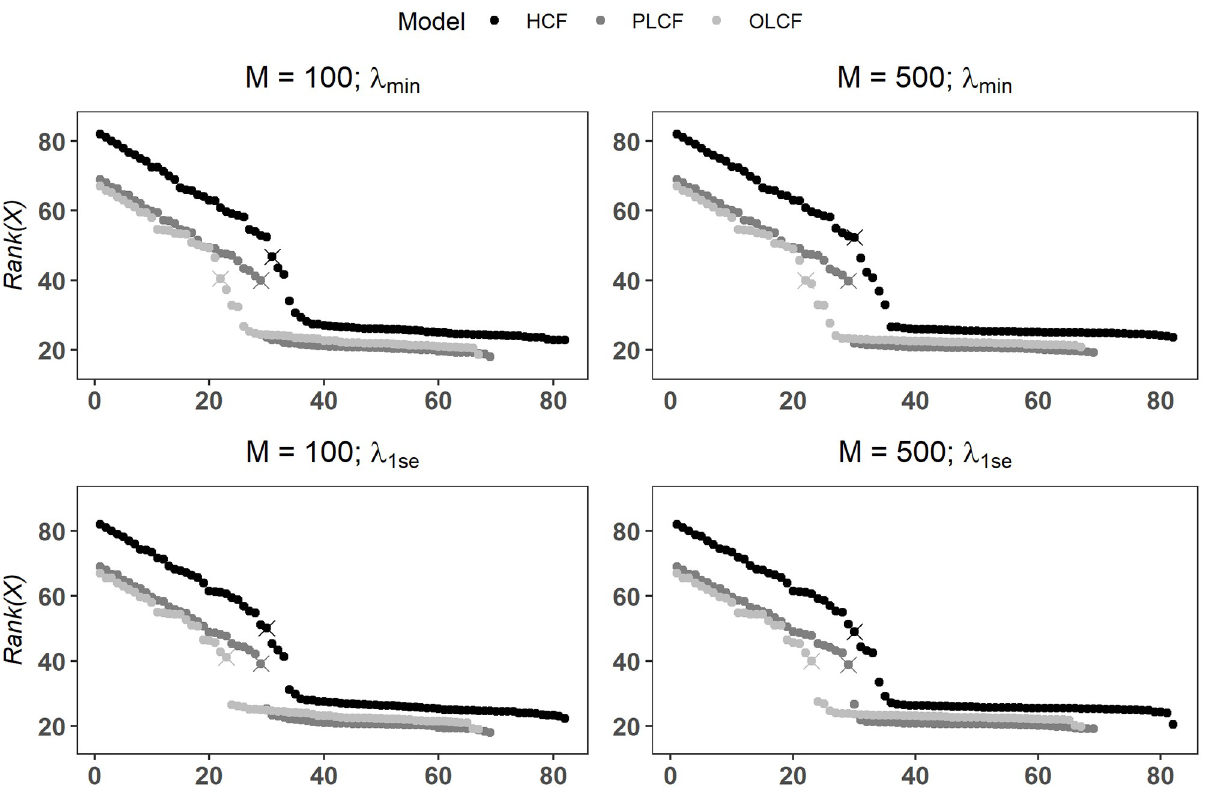
Fig 8. Ridge regularization-based variable ranks scores computed using SVRS algorithm for various wildland fire occurrence models. Symbol × marks a changepoint point in sorted Rank ( X ) values where variables falling to the right of × are classified as noise covariates. (Table 7). We refer the reader to Nadeem et al. [29] for a detailed discussion of the relevance of selected covariates to the wildland fire occurrence process in British Columbia, Canada.